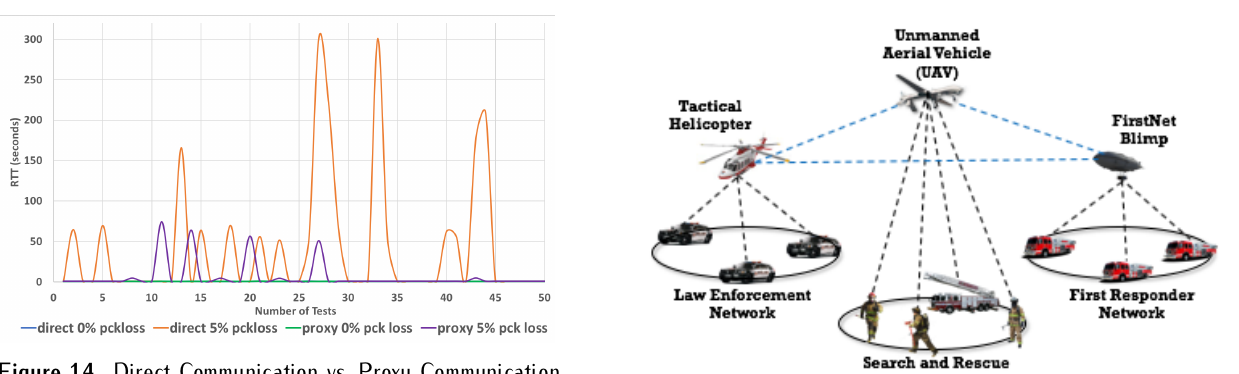
Figure 14. Direct Communication vs. Proxy Communication